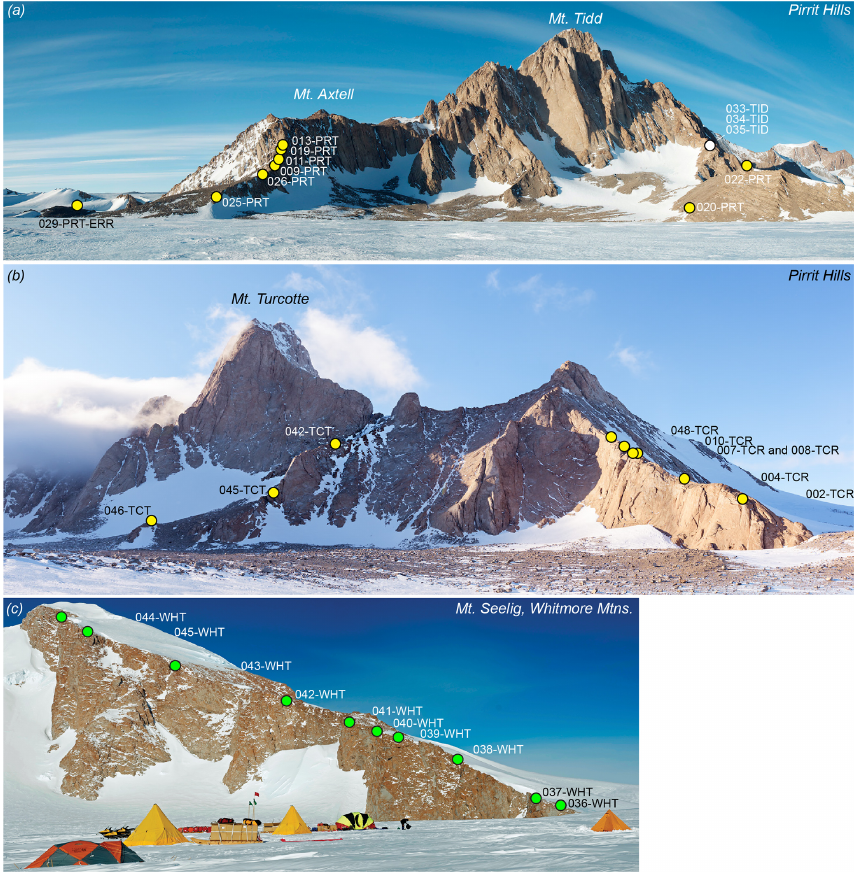
Figure 3. Views facing south of Mts. Axtell and Tidd (a) and facing west of Mt. Turcotte (b) at the Pirrit Hills. (c) View to the south of the northwest ridge of Mt. Seelig. Note that all circles in (a) and (b) denote samples of glacial deposits, while circles in (c) denote bedrock samples. The white circle in (a) represents samples from the depositional limit on Mt. Tidd, which have not been analyzed. Circles are labeled with abbreviated sample names. Mt. Turcotte samples, as well as the unanalyzed samples from Mt. Tidd, begin with the prefix “16-PRT-” (e.g., 16-PRT-042-TCT); all other samples begin with the prefix